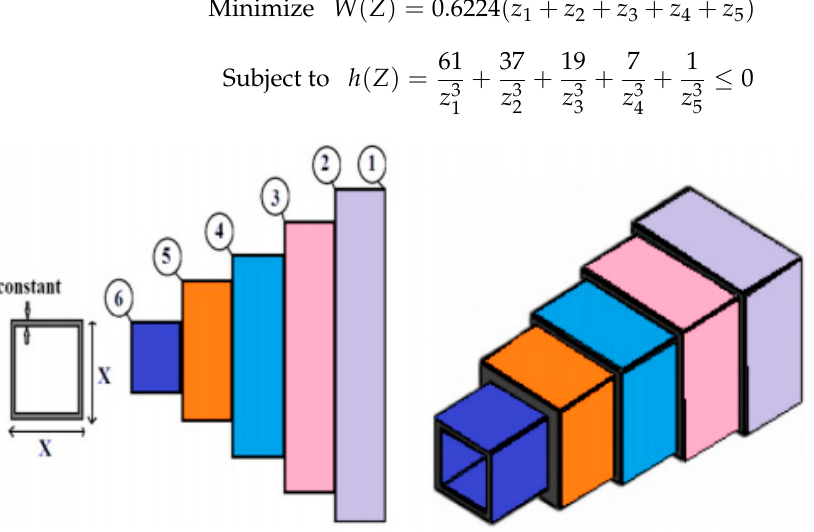
Figure 11. Sketch map of the cantilever beam design problem [56].